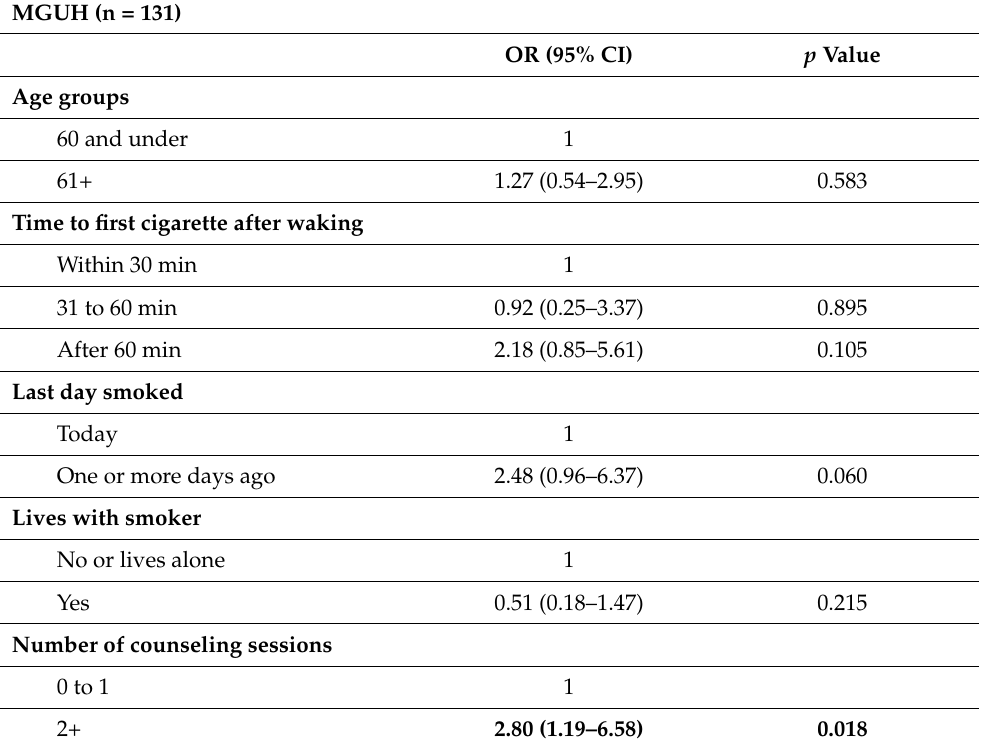
Table 4. Adjusted logistic regression analysis: predicting 7-day point prevalence abstinence at 6 months at